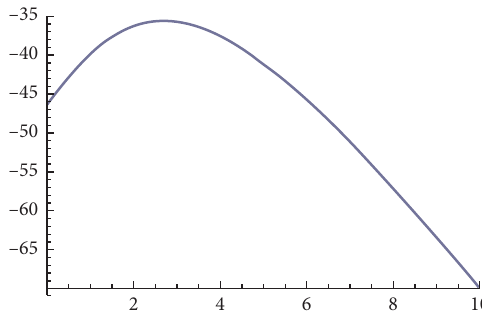
Figure 5: Profile log-likelihood function of λ .